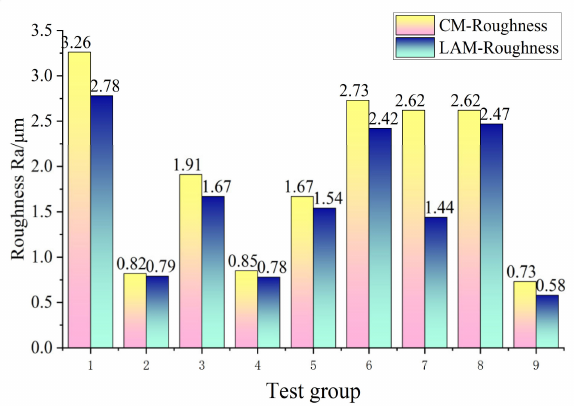
Figure 9. Comparison of surface roughness of the machined material via conventional machining and laser-assisted